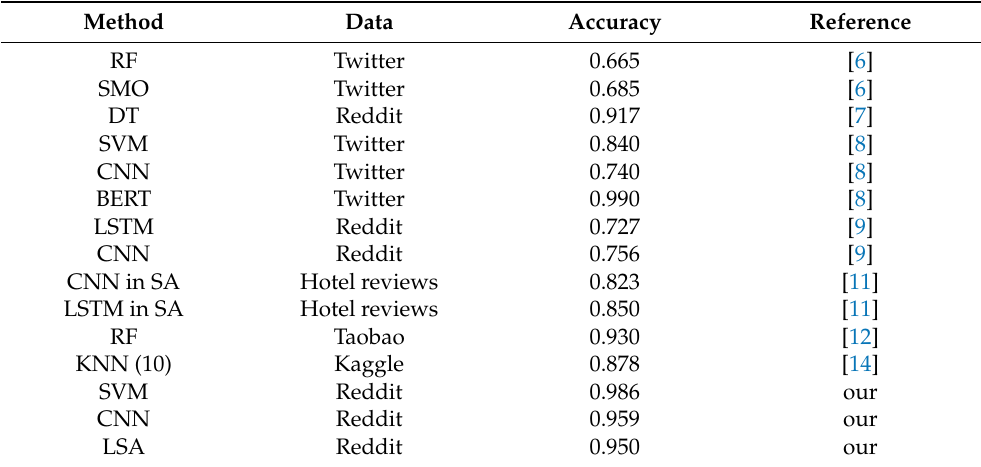
Table 14. Comparison of various approaches to build models for recognition of troll users in online